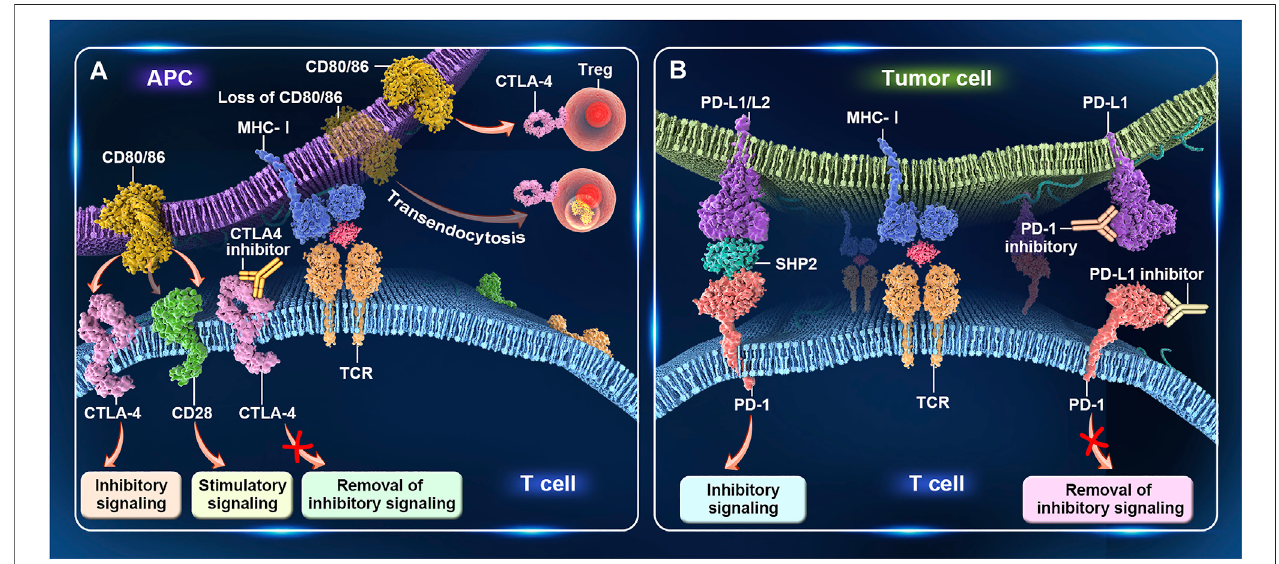
FIGURE 1 | Immunomodulatory effects of CTLA-4 and PD-1. (A) CTLA-4 regulates T-cell activation. When CTLA-4 is overexpressed on activated T cells, it competes with CD28 for binding to CD80/86 on antigen-presenting cells (APCs), thereby inhibiting T-cell activation. Treg-speci fi c deletion of CTLA-4 or the CTLA-4- mediated capture of CD80/86 from APCs through endocytosis leads to aberrant T-cell activity. (B) PD-1 regulates T-cell activation. PD-1 is mainly expressed on activated Tcells.AfterbindingtoPD-L1/L2ontumorcells,inhibitorysignalstransmittedtoTcells.PD-1antibodiesblocktheinteractionbetweenPD-1andPD-L1/ PD-L2, resulting in the relief of these inhibitory signals, enhanced T-cell activity, and, fi nally, tumor cell lysis.